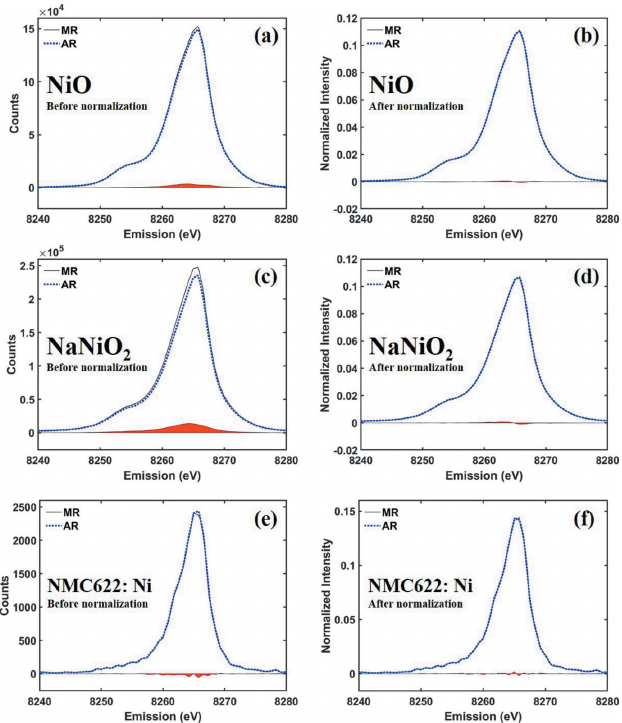
Figure 4 Ni K (cid:2) 1,3 spectra of nickel oxides converted by MR and AR. The solid black and the dotted blue lines represent MR and AR, respectively, for ( a , b ) NiO before and after normalization, ( c , d ) NaNiO 2 before and after normalization, and ( e , f ) NMC622 at Ni K (cid:2) 1,3 emission spectra before and after normalization, respectively. The red colored areas indicate the differences between the MR and AR